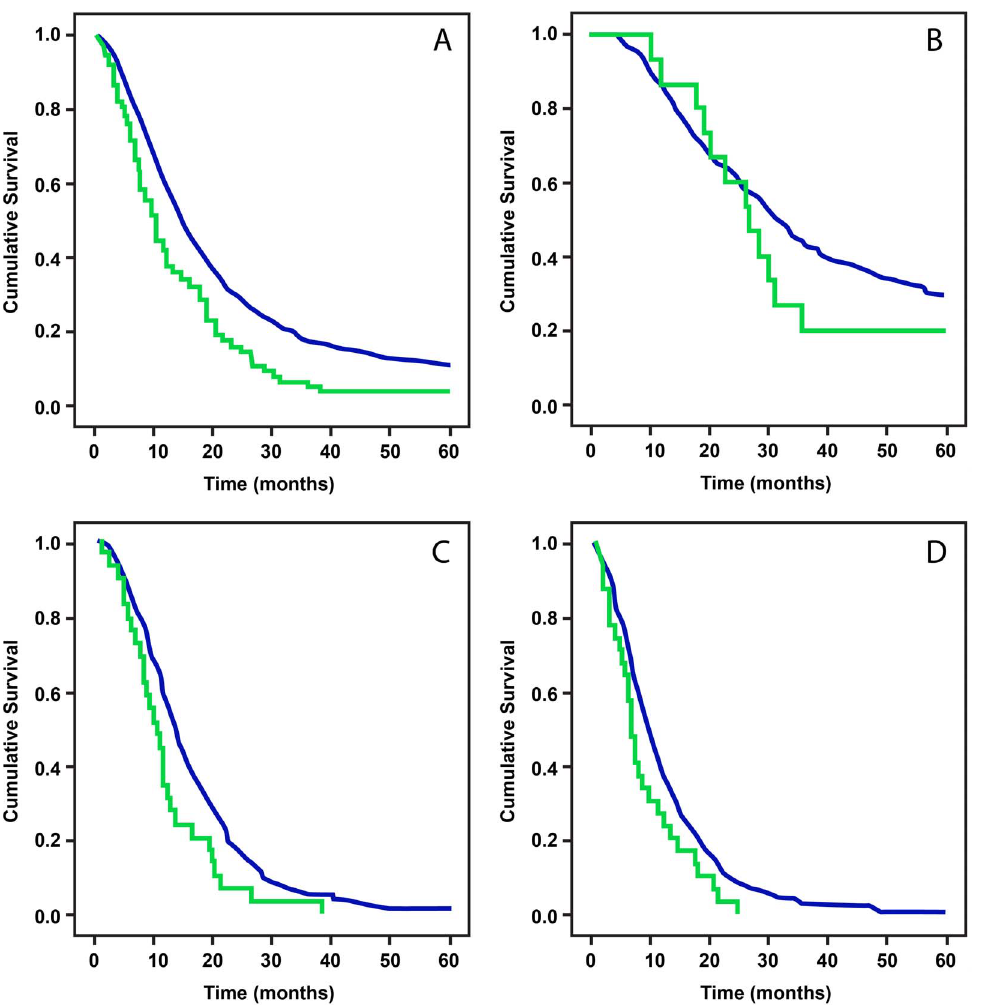
Figure 3. Plot of overall survival curve in patients with all patients (A), patients with localized (B), locally advanced (C) or metastatic tumors by SMAD4 SNP rs2704733 genotype. Blue line: AA genotype; green line: AG/GG genotype. AA genotype was associated with an improved survival in the entire study population. On subgroup analysis, this survival difference was more relevant for advanced disease stage. P values by log-rank test are , 0.0001, 0.369, 0.007, and 0.031 for panels A, B, C and D,